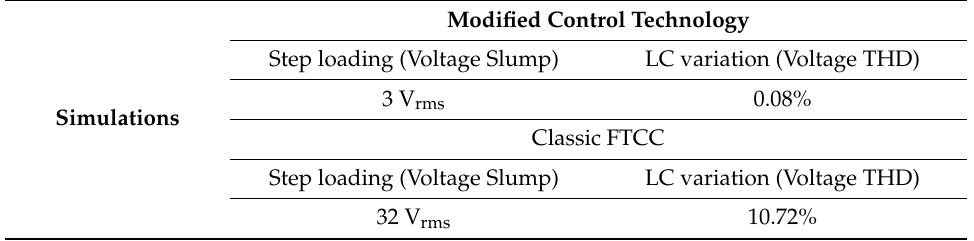
Figure 7. Simulated waveforms in response to the LC variation for the classic FTCC (50 V/div). Table 2. Simulated output-voltage slump and voltage total harmonic distortion (THD) under a step